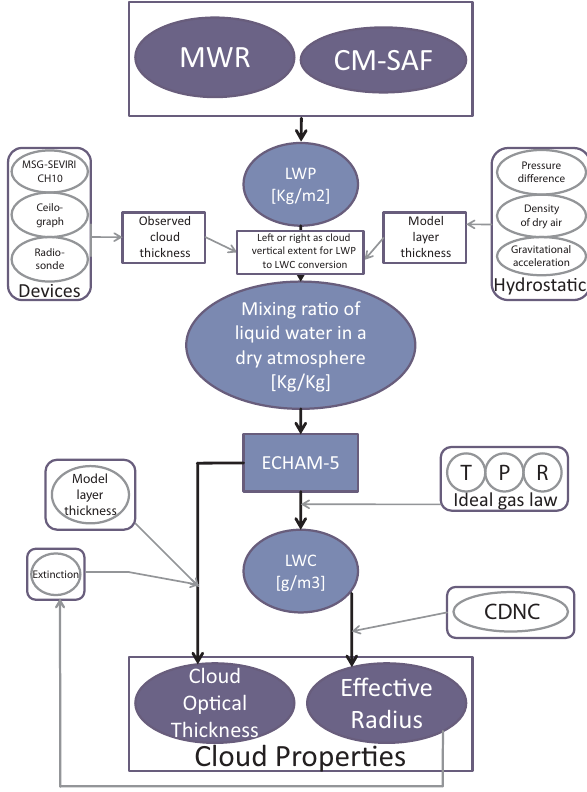
Fig. 2. Schematic overview on the dependences in the transforma- tion from measured liquid water path to cloud properties in the